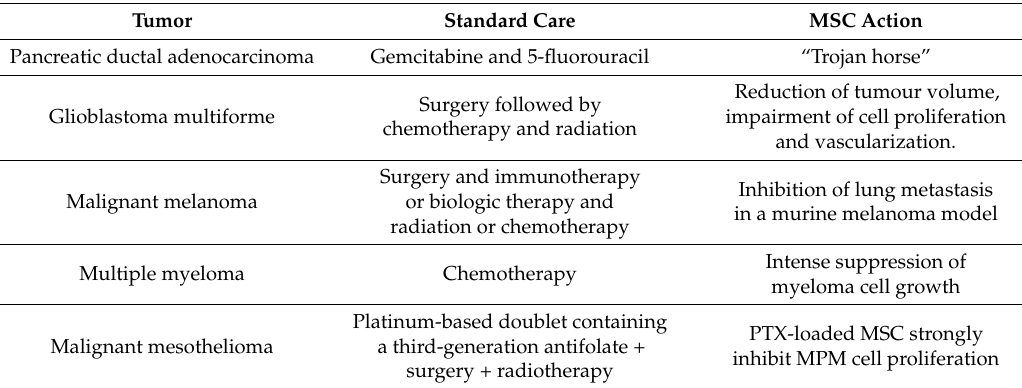
Table 1. Possible oncologic indications for clinical use of